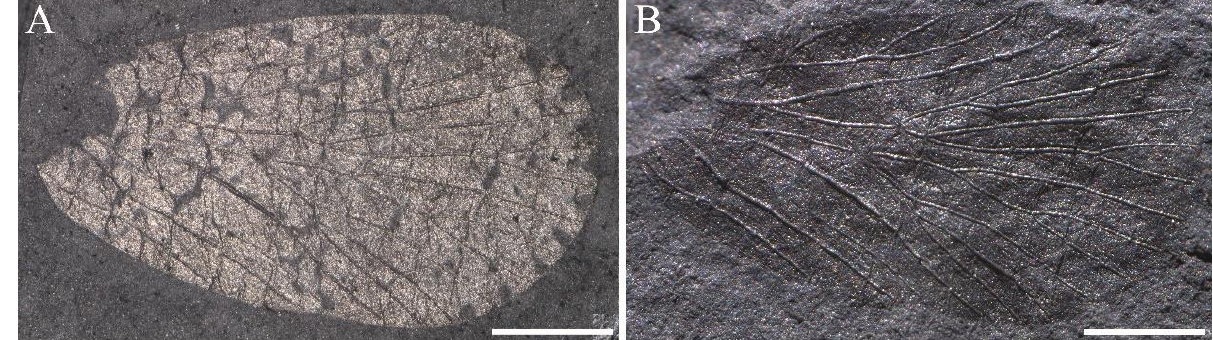
Figure 9. Sinoagetopanorpa minuta sp. nov., NIGP200920 (holotype). ( A , B ) Photographs of part; ( C , D ) Photographs of counterpart; ( A , C ) were taken when specimens were immersed under 70% alcohol in vertical reflected light; ( B , D ) were taken in oblique reflected light. Scale bars represent 1 mm in ( A – D ). Description . Forewing with apex rounded and broad, length 4.8 mm, width 2.6 mm, L/W 1.9; wing with dark color, more than 10 irregular hyaline patches focused on anterior and basal wing, some crossveins accompanied with small hyaline patches, a hyaline rounded triangular spot at apex of each interface of Rs and M 1-3 branches; Sc terminated at a distance of 2/3 from wing base; R 1 single and nearly straight; Rs five-branched, stem Rs 1+2 length 0.6 mm, stem Rs 3+4 length 0.3 mm; Rs 1+2 forking at the same level as M 1+2 fork; Rs 4 forking apically; stem Rs 4a+b twice as long as its branches; a crossvein connecting basal Rs 2 and Rs 3 ; M six-branched, M 2 and M 4 both bifurcated into two branches, stem M 1+2 as long as stem M 2a+b and slightly longer than stem M 3+4 , stem M 4a+b very short; Rs 3+4 fork and stem M 1+2 , Rs 4a+b fork and M 1 , stem M 2a+b and M 3 connected by a crossvein, respectively, crossvein m-cua connecting M 4a+b fork and CuA; CuA curved after the crossvein m-cua, CuP straight; the crossvein between CuA and CuP robust and nearly horizontal; M + CuA fork proximal to R 1 + Rs fork, R 1 + Rs fork slightly proximal to the first fork of Sc; three anal veins visible, A 3 short, very close to wing margin. Sinoagetopanorpa elegans sp. nov. (Figures 10, 11 and 19F; ZooBank LSID urn:lsid:zoobank.org:act:7BE01613-3A97- 4141-9F94-248339997070). Etymology . The specific epithet is derived from the Latin elegans , indicating the well- preserved four wings. Type locality and horizon . Yinping Mountain, Chaohu City, Anhui Province, China; Yinping Formation (Capitanian). Diagnosis . Forewing with numerous dark-colored spots, base narrow, a hyaline rounded triangular spot at apex of each interface of Rs and M branches; Rs 4a+b forked late, A 3 distinctly developed, the area between A 3 and wing margin broad. Hind wing with Rs 4a+b forked very late, R 1 with three terminal branches.